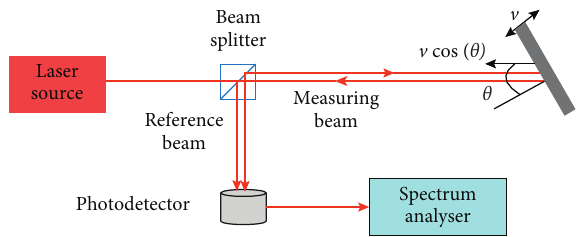
Figure 3: Basic LDV